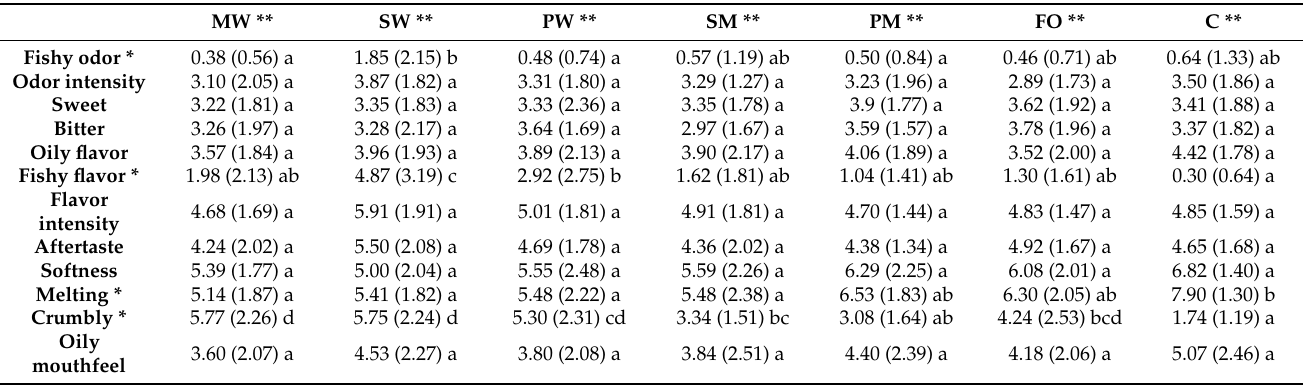
Table A1. Mean intensities and standard deviations (in brackets) of attributes in the descriptive analysis of the dark chocolate models. The statistical differences between the samples are marked with letters a-f (Tukey’s HSD test, p < 0.05). The lowest values are marked with letter a, and samples with the same letter on the same row are not different from each